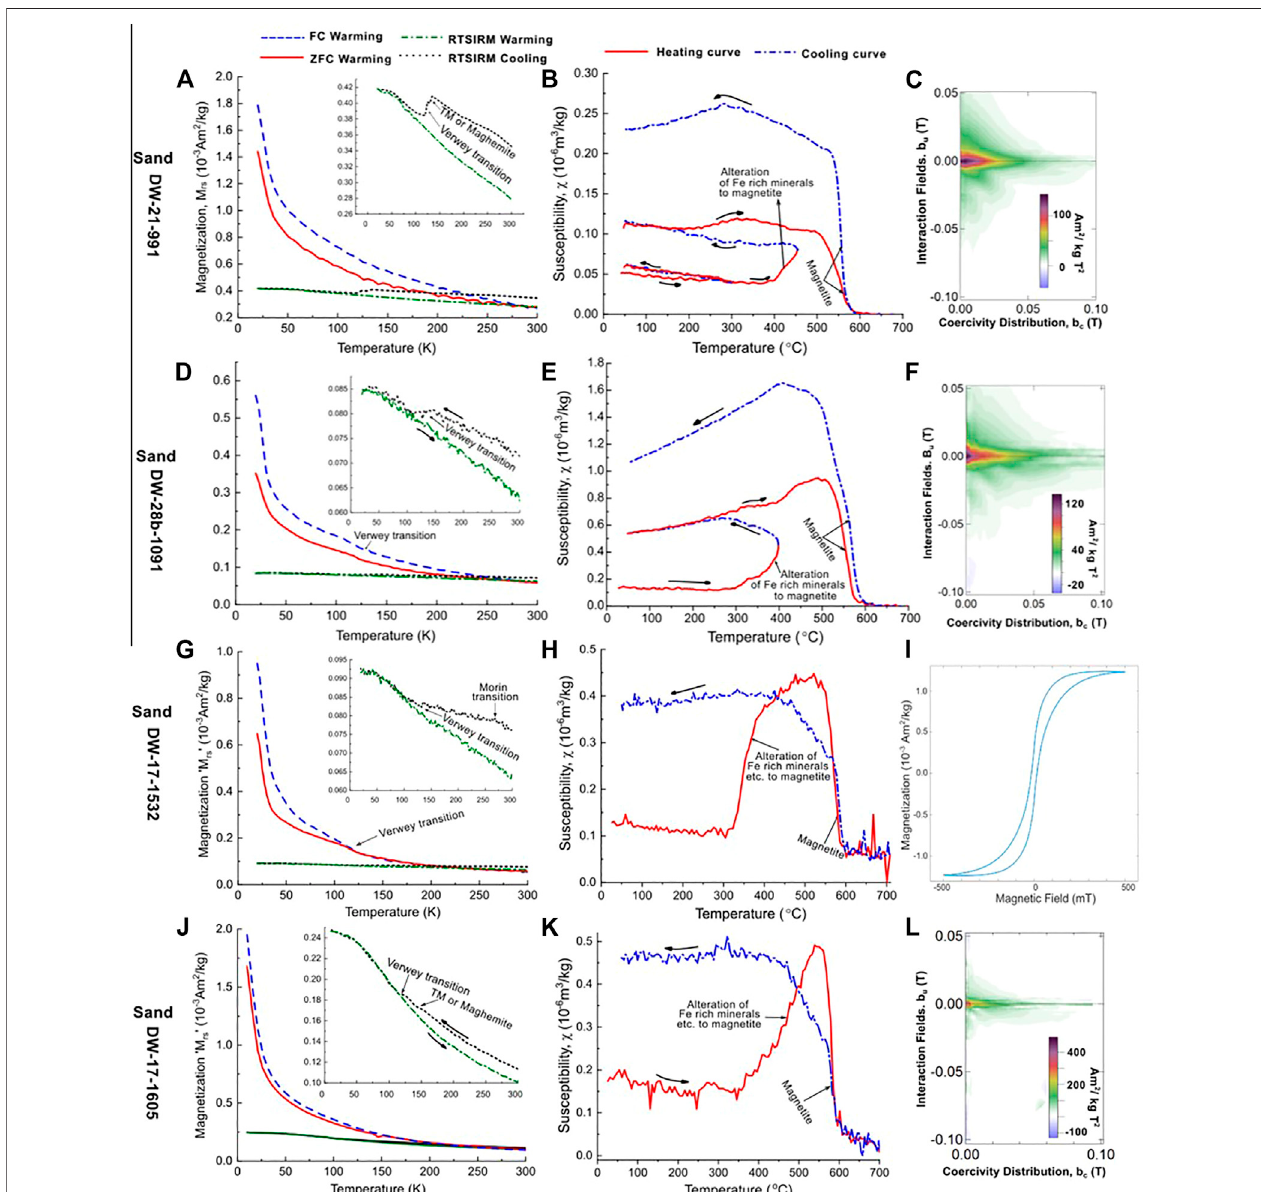
FIGURE6| ExampleresultsfromLTM,HT- χ andFORCmeasurementsforthebackgroundsamples;DW-21-991,DW-28b-1091,DW-17-1532andDW-17-1605 are shown on (A – C) , (D – F) , (G – I) and (J – L) , respectively. The background samples measurement curves suggest the presence of magnetite and titanomagnetite (or their oxidized versions), hematite and potentially titanohematite. Note that TM stands for titanomagnetites. The subsurface depth (in m) of the samples ’ collected is highlighted in the sample name, i.e., the last segment of their names.